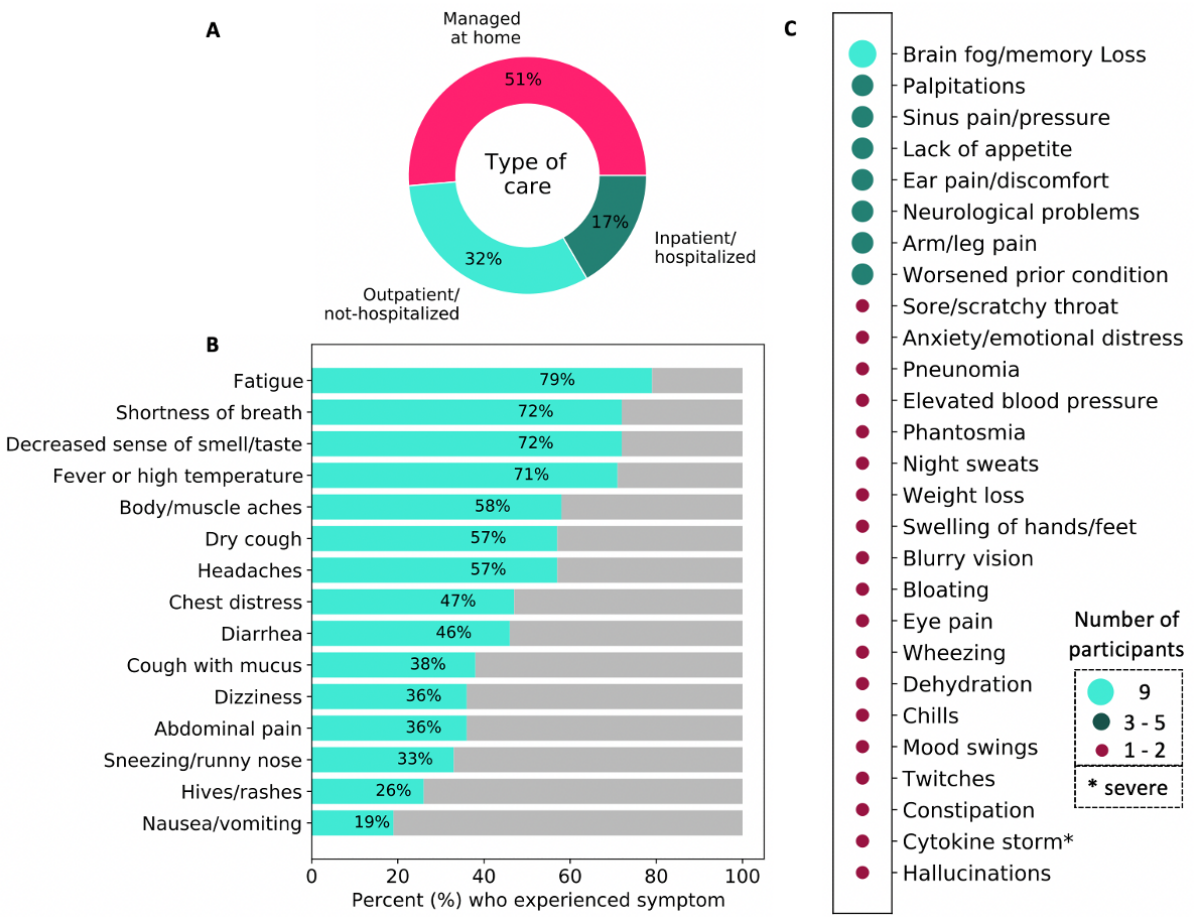
Figure 2. Overview of the type of care received and COVID-19 symptoms reported by participants in this study. (A) The type of care received by COVID-19 survivors; (B) list and prevalence of more common COVID-19 symptoms; and (C) other less-documented symptoms of